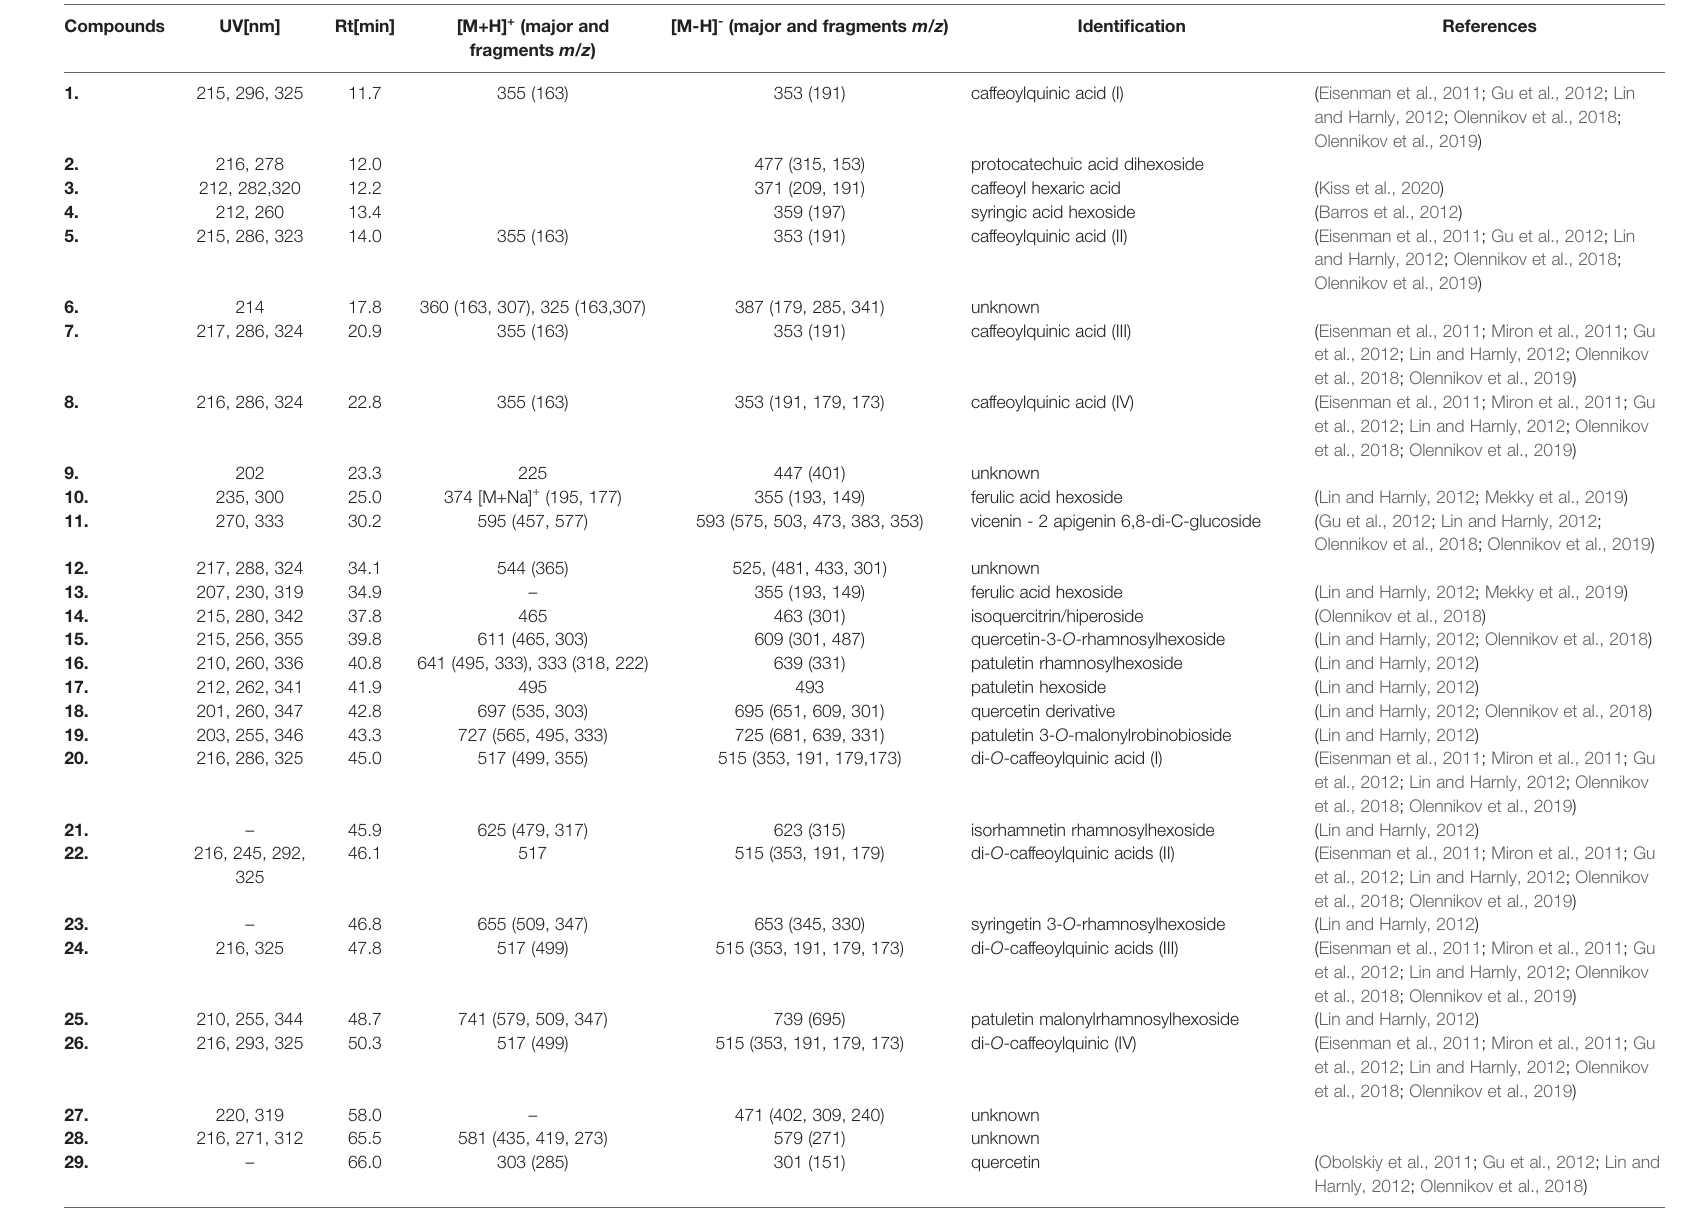
TABLE 1 | Constituents annotated in ADI extract by UHPLC-DAD-ESI-MS.